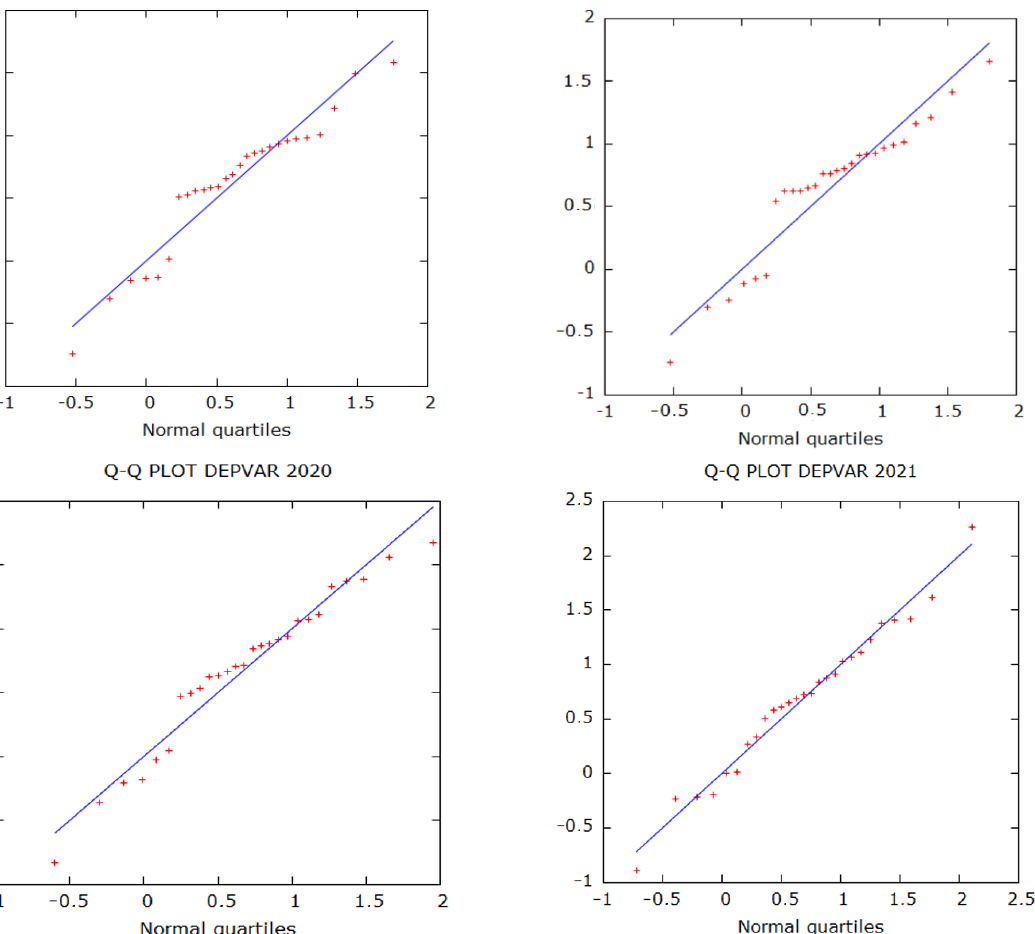
Figure 1. Trend distribution of the production function by annual Normal Plot diagram of the dependent variable of the model.